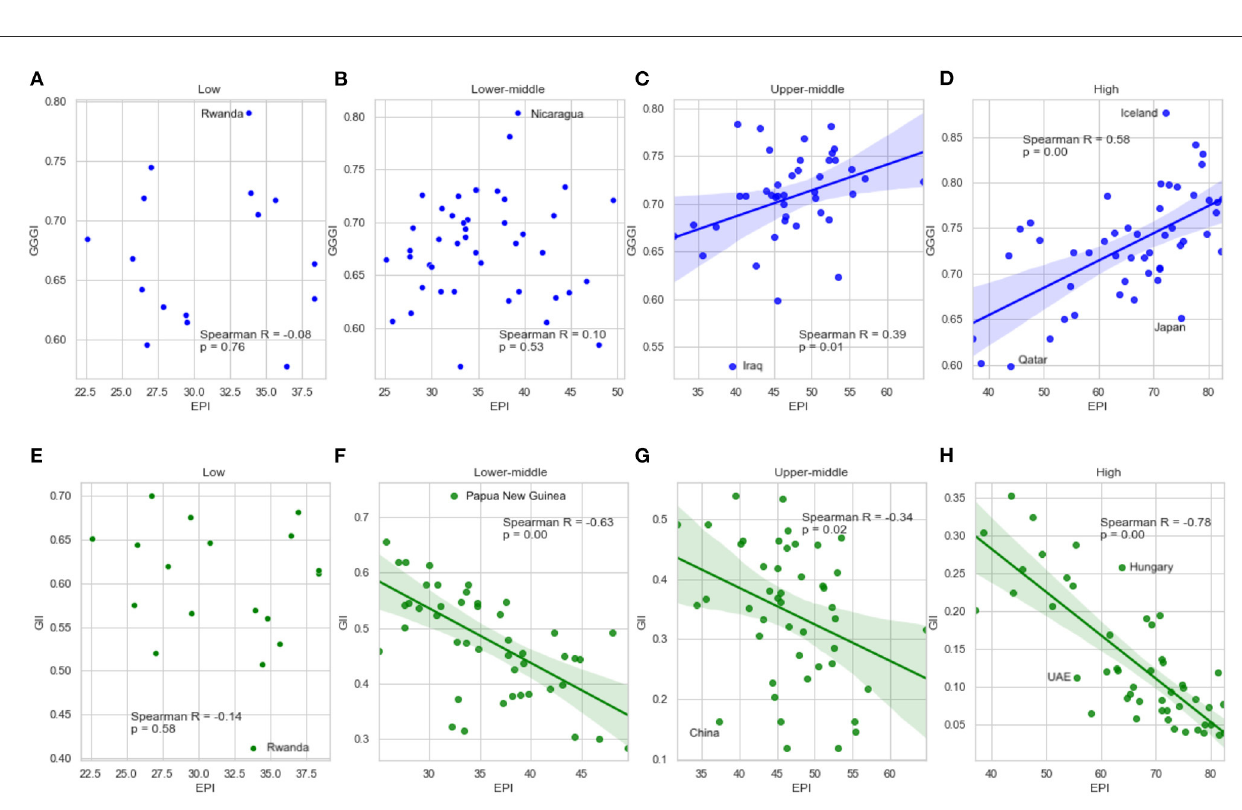
FIGURE2 (A–D) Correlations between GGGI and EPI per income category: (A) low income, (B) lower-middle income, (C) higher-middle income, and (D) high income. (E–H) Correlations between GII and EPI per income category: (E) low income, (F) lower-middle income, (G) higher-middle income, and (H) high income. Regression lines are drawn in the cases of statistically significant correlations ( p <